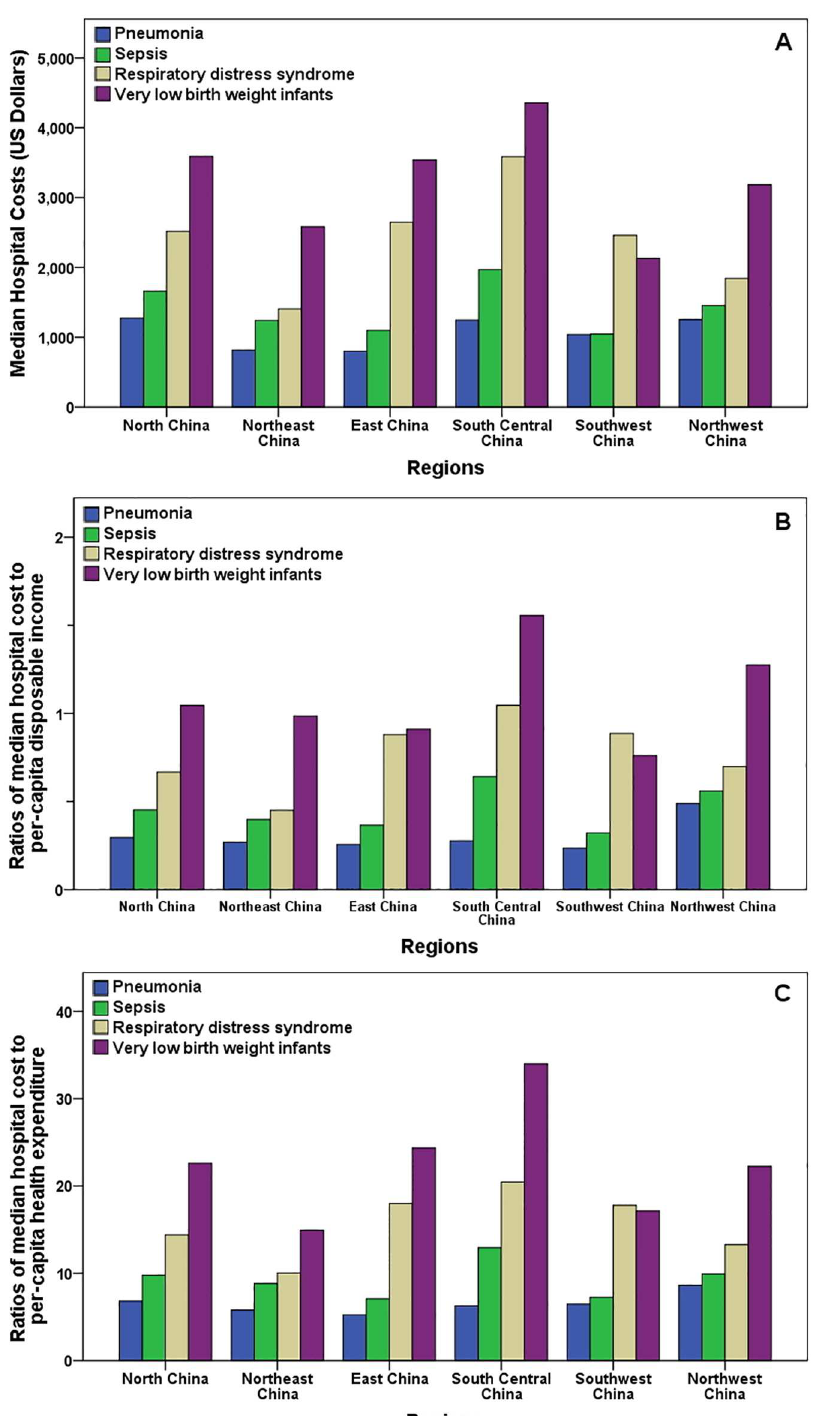
Fig 2. Diseaseexpenditures of four common newborn diseasesby regions during 2008–2010. (A) Medianhospital costs by regions, and the P -valueswere all less than 0.001forregionalcomparisons of pneumonia, sepsis, RDS, and VLBW infants. (B) Ratios of medianhospitalcost to per-capitadisposable income of local urban residents by regions, and the P -values for regionalcomparisons of pneumonia, sepsis, RDS, and VLBW infants were 0.237, 0.026, 0.003, and 0.092 respectively.(C) Ratios of median hospitalcost to per-capita health expenditure of local urban residentsby regions, and the P -valuesfor